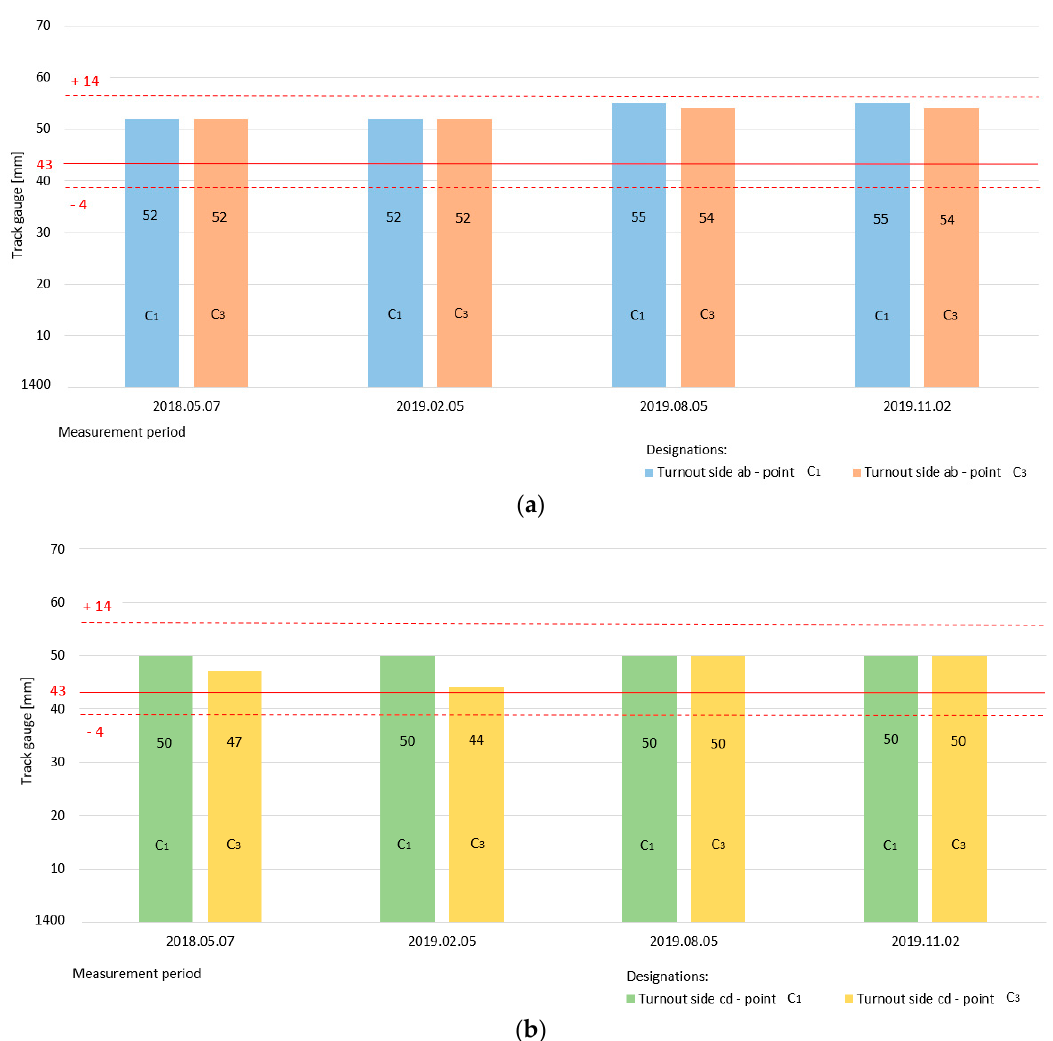
Figure 12. The track gauge of the diverted track in turnout number 9: ( a ) turnout side “ab” Figure12. Thetrackgaugeofthedivertedtrackinturnoutnumber9: ( a )turnoutside“ab”(measurement (measurement at c 1 , c 3 ); ( b ) turnout side “cd” (measurement at c 1 , c 3 ). at c 1 , c 3 ); ( b ) turnout side “cd” (measurement at c 1 , c 3